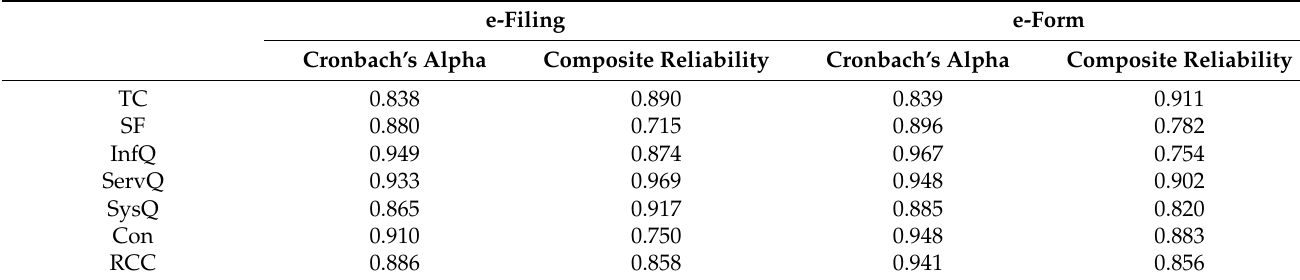
Table 4. Reliability